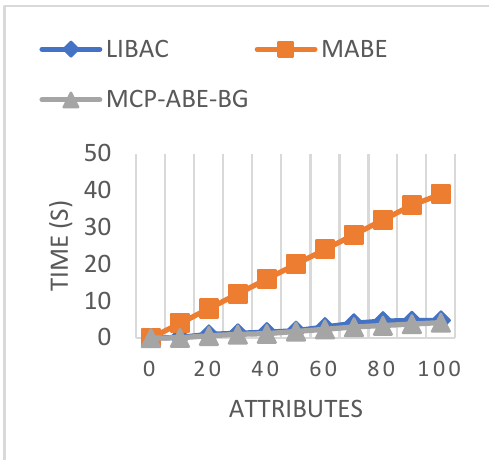
Figure 11. Cipher text size comparison.